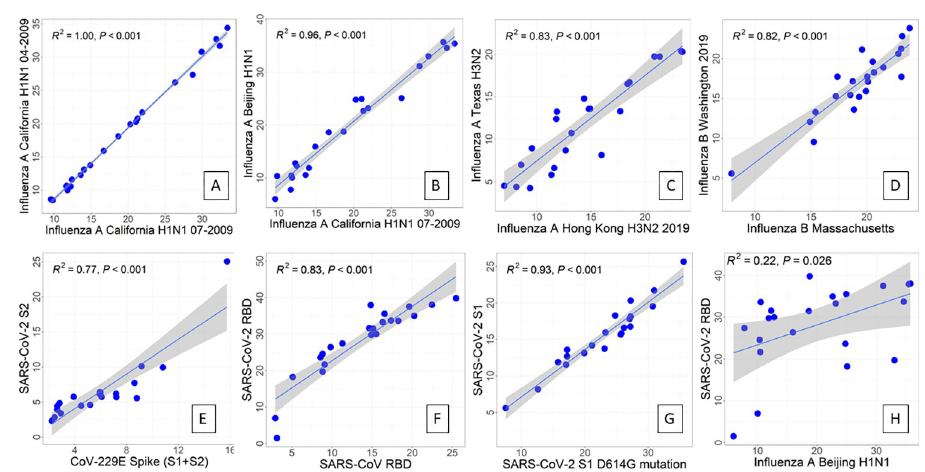
Fig 5. Selected correlations between proteins by linear regression. Plots were made with data from samples drawn within two weeks of the second dose of a SARS-CoV-2 mRNA vaccine. Points are individual samples, and lines are linear regressions with a grey band indicating standard deviation. Plots A-G show high positive correlations. Plot H shows two proteins significantly not